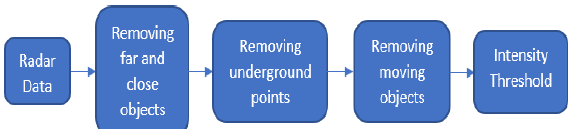
Figure 1. The Block diagram shows the preprocessing